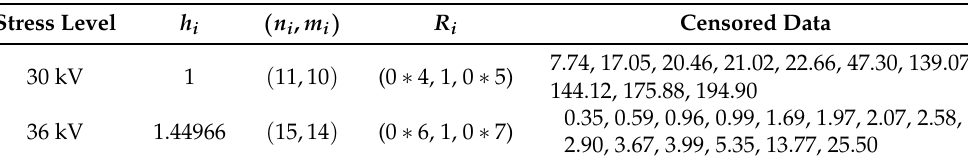
Table 10. The constant-stress progressive Type-II censored data.